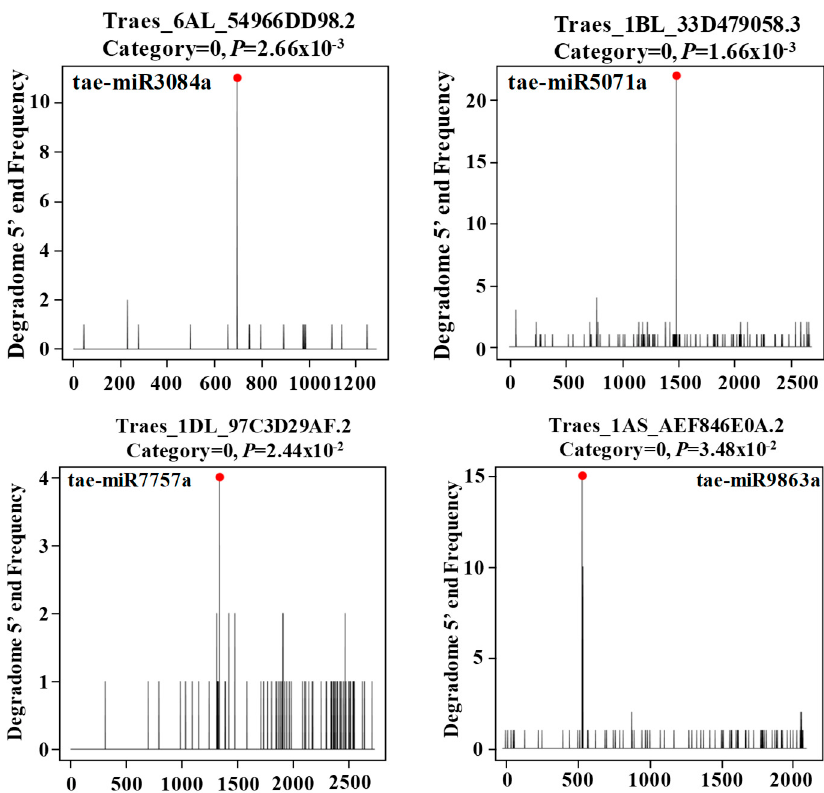
Figure 3. Target plots (T-plots) of miRNAs characterized in the degradome datasets: The abundance of signature tags was plotted along the indicated transcripts. The red dots indicate the predicted cleavage sites on the x-axis, and the black lines indicate the signatures produced by miRNA-directed cleavage.